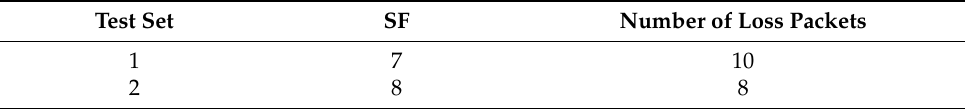
Table 6. Analysis of residual loss using double GW for ED8.